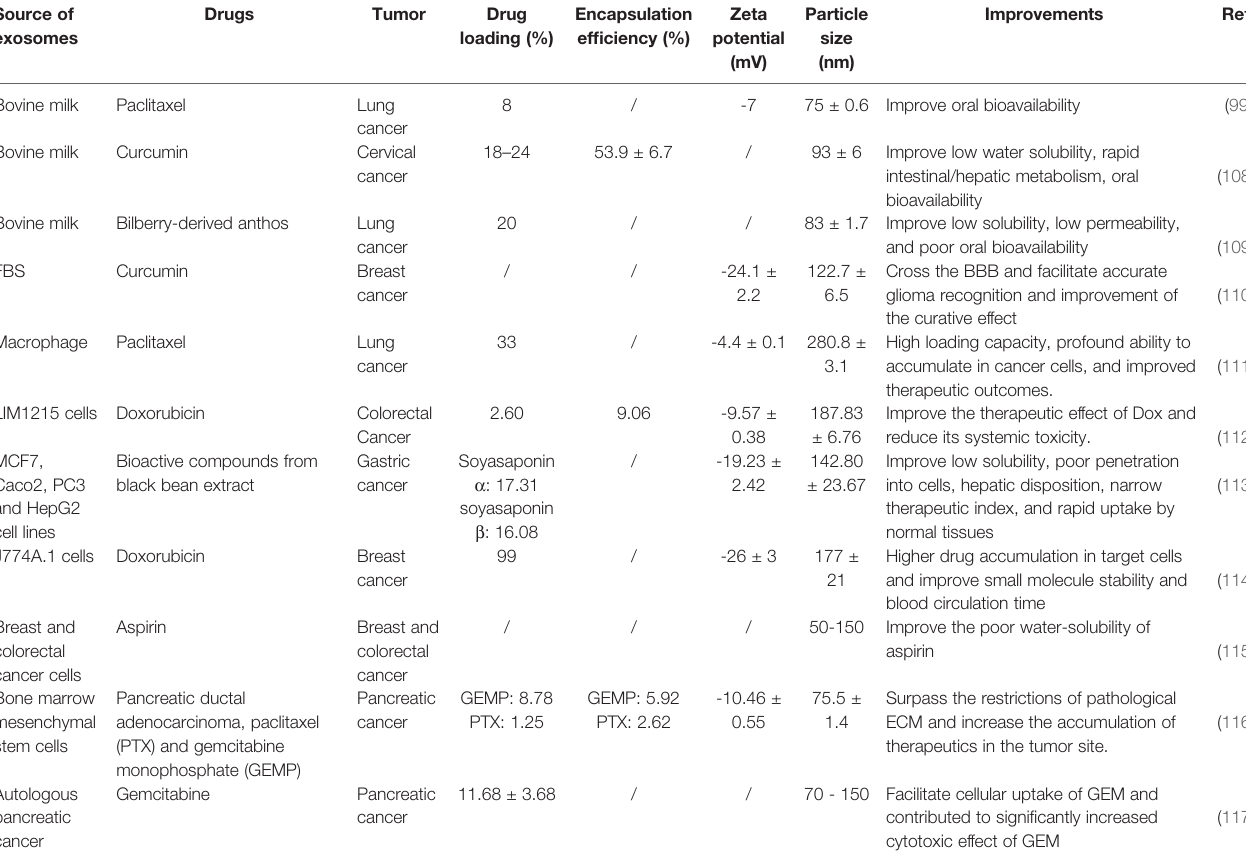
TABLE 3 | Exosome-mediated anti-tumor drug